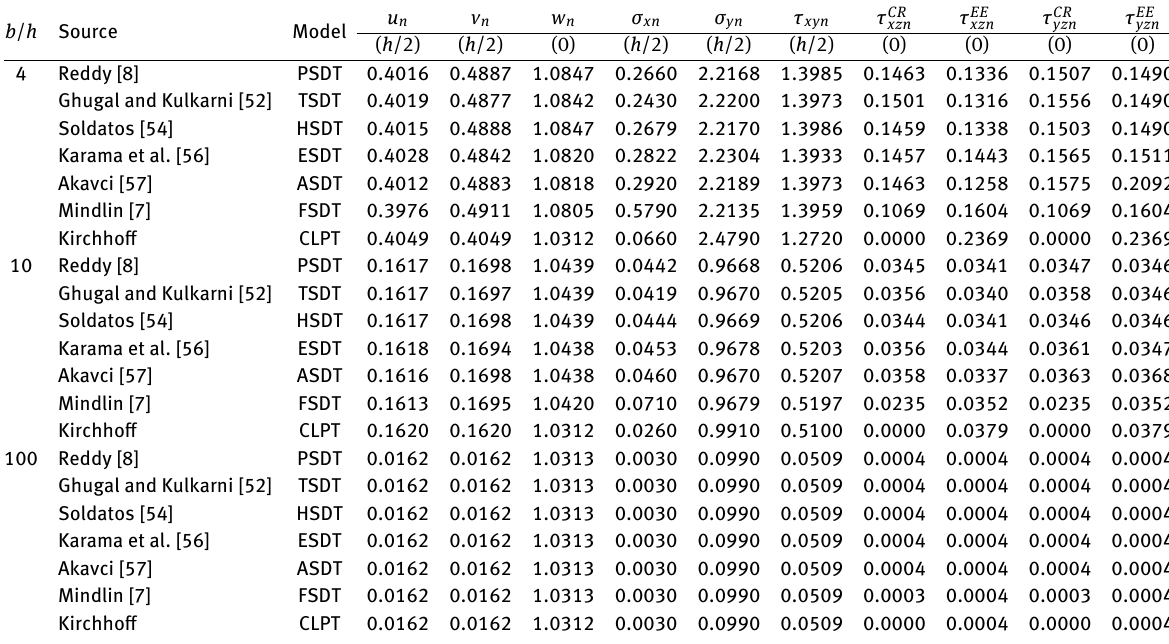
Table 1: Comparison of thermal displacements and stresses of simply supported square ( b = a ) orthotropic plate subjected to sinusoidally distributed linear thermal loading.